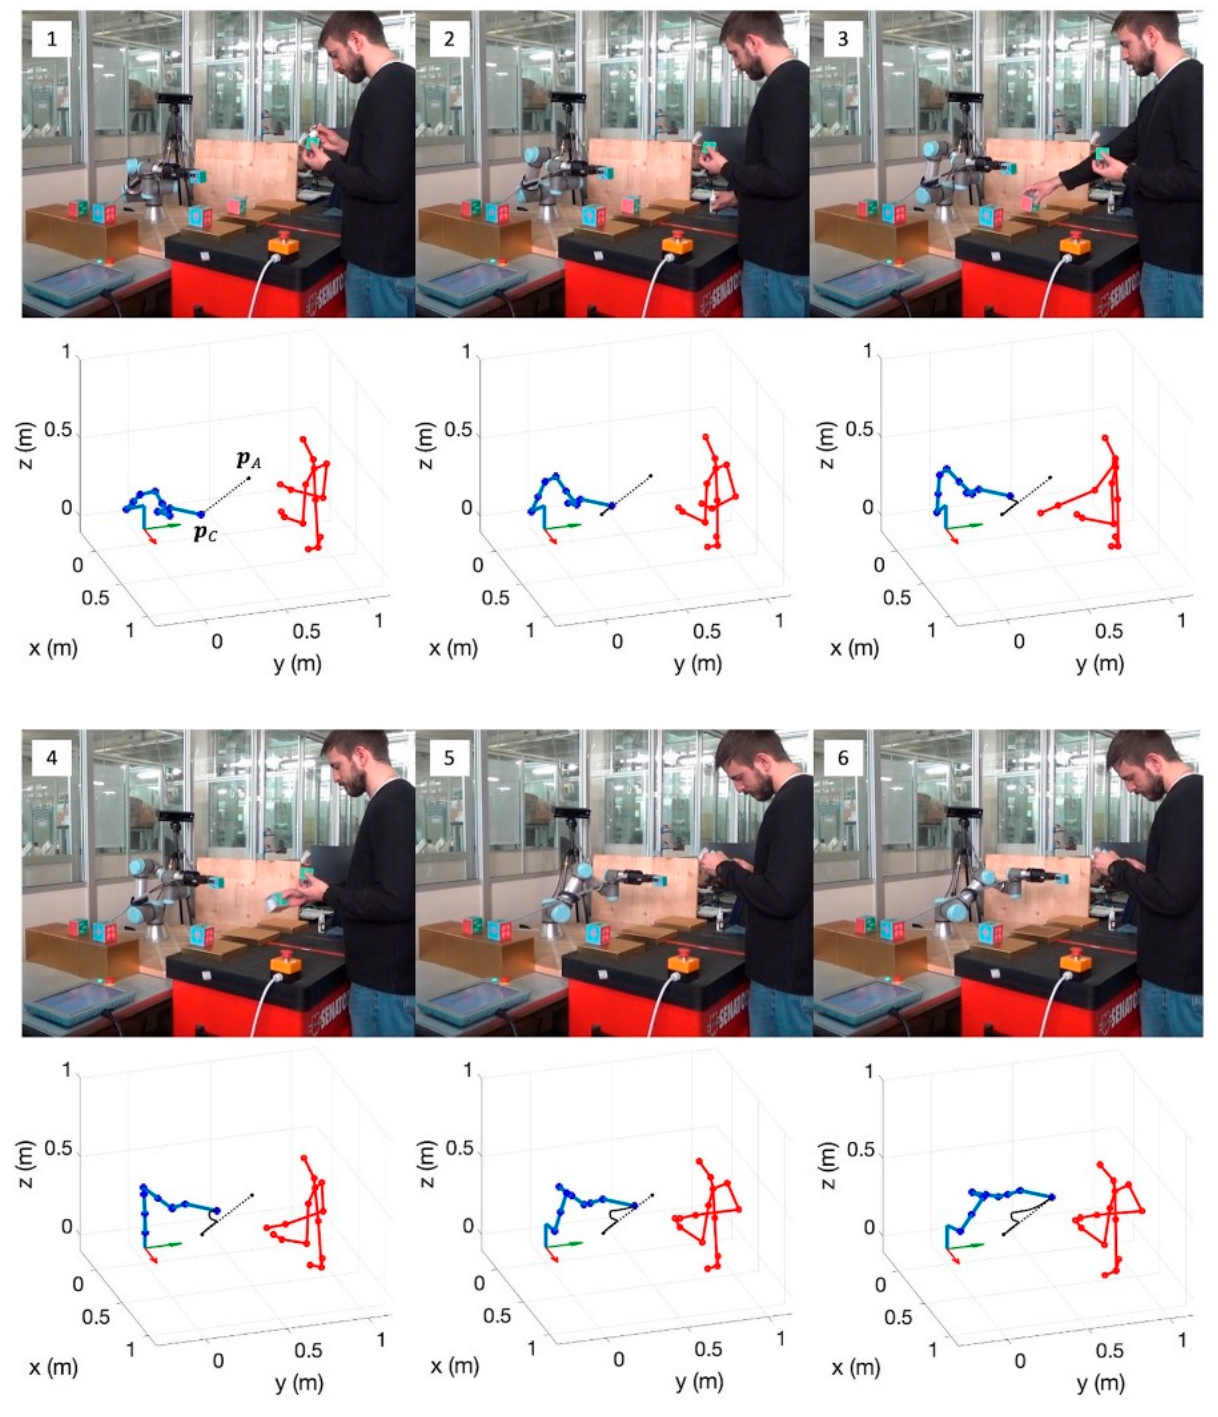
Figure 9. Frames of the collision avoidance during the “Place a ↦ A” stage. The possibility to carry out the task with the highest level of collaboration brings significant advantages in terms of task times. At the top of Figure 11, the workflow diagram of the proposed assembly cell is shown. In this case, which represents a responsive collaboration, the human and the robot complete their task in the same time interval, resulting in a mean cycle time of 112 s. The human and robot tasks run in parallel and the robot collaborates while the human executes value added operations, i.e., actions that carry on the assembly